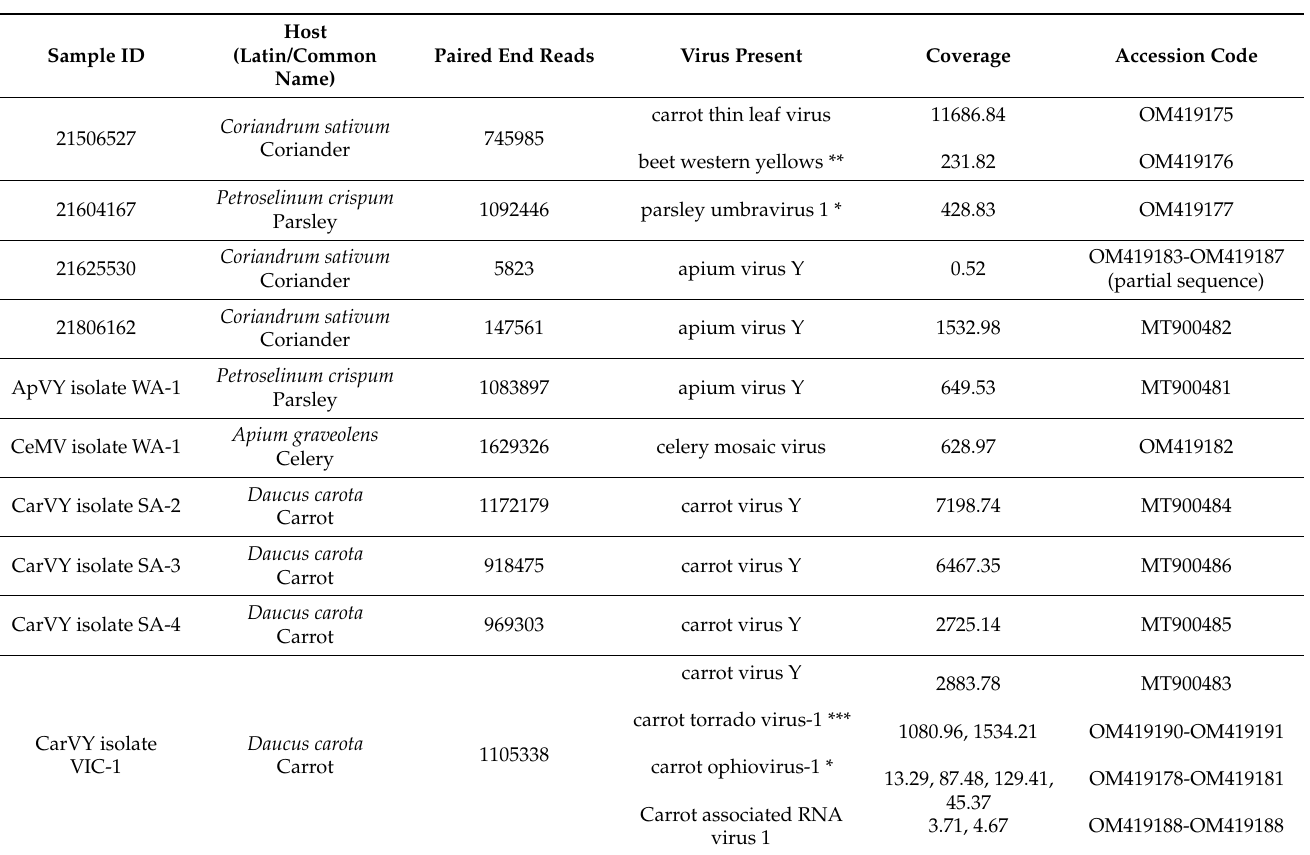
Table 1. Metagenomes of previously unsequenced viruses obtained from preserved historical samples from apiaceous plants. * indicates tentative virus name for a first record, ** indicates a new host record, and *** indicates a new country